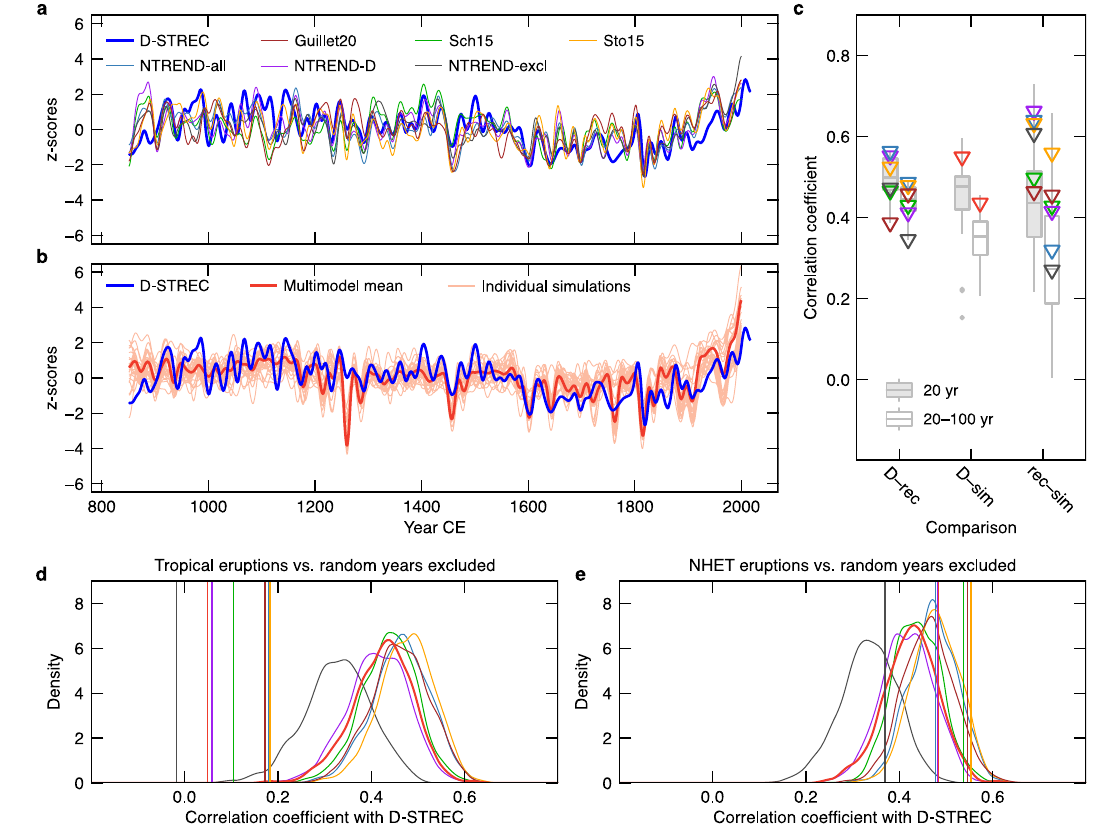
Fig. 4 | Comparison ofD-STREC with Northern Hemisphereextratropic (NHET) summertemperaturereconstructionsandsimulations.a D-STRECcomparedto six tree-ring-based reconstructions. Guillet20: Guillet et al. 39 ; NTREND-all and NTREND-D:the all-proxyand the maximumlatewood densityonly reconstructions in Wilson et al. 5 , respectively; NTREND-excl: Northern Hemispheric mean of the gridded NTREND reconstruction 14 after excluding the northeastern North Amer- ican components (Supplementary Fig. 8); Sch15: Schneider et al. 38 ; Sto15: Stoffel et al. 37 . b D-STREC compared to an ensemble of 25 CMIP5 full-forcing near-surface May – August temperature simulations averaged over land 30 – 90°N. In a and b , all the time series are smoothed using a 20-year low-pass Butterworth fi lter to high- light multidecadal and long-term variations, and are transformed to z-scores with respecttothe1000 – 2000timeperiod. c Pearson ’ s r amongtheD-STRECandNHET summer temperature series. 20 yr: 20-year smoothed series over the 851 – 2000